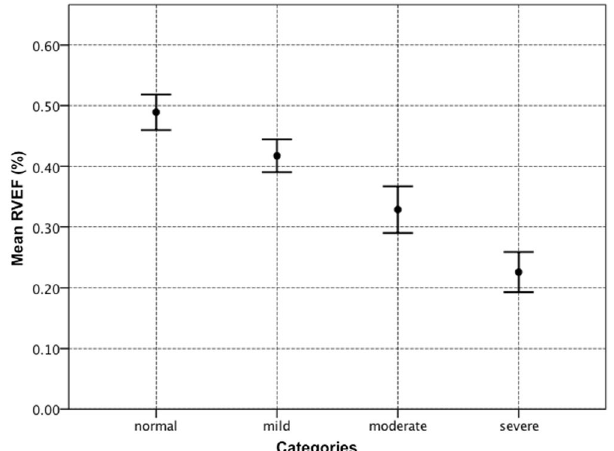
Figure 3. Mean RVEF stratified by RV/LV volume ratio severity. Error bars represent standard error of the mean for RVEF. The severity of RV dilation, represented by each category of the RV/LV volume ratio, was related to significantly higher degrees of RV dysfunction.